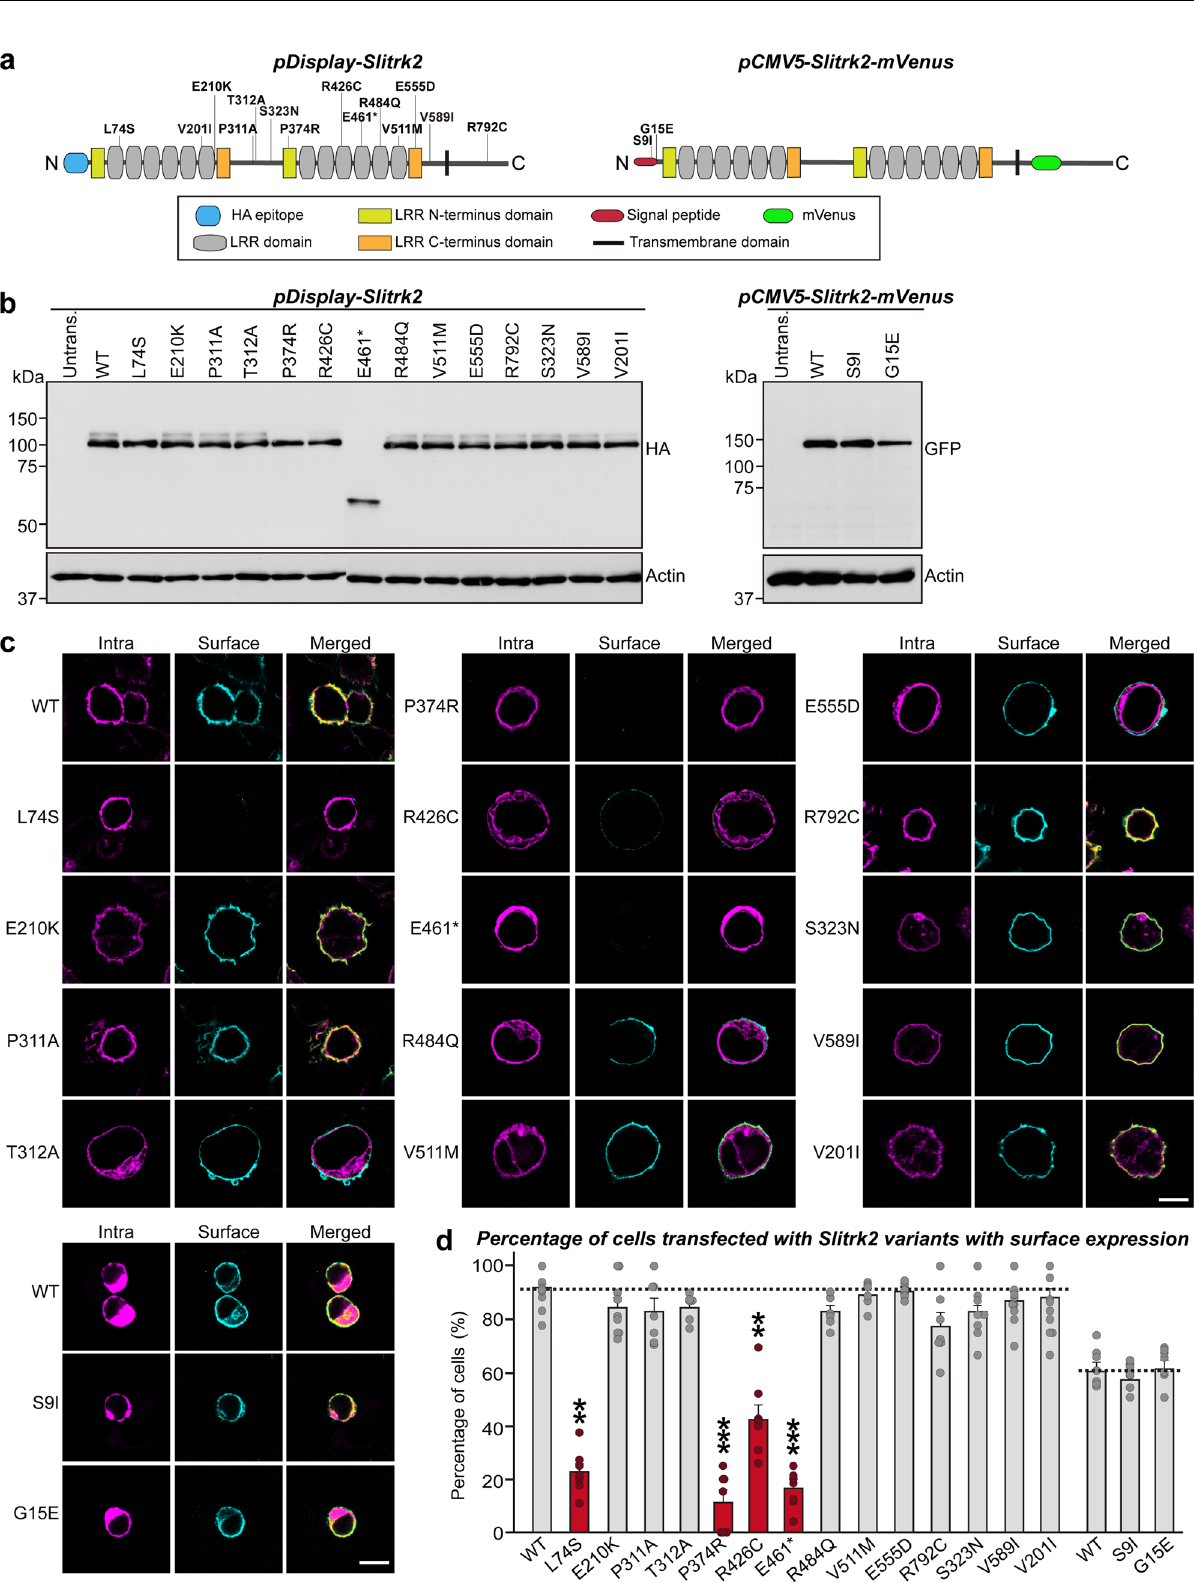
around SLITRK2-expressing HEK293T cells, whereas L74S, P374R, R426C, and E461 * were functionally inactive in recruiting both VGLUT1 and GAD67, as expected given their impaired surface expression levels and PTP-binding activities (Fig. S11; see Figs. 3c, d, S6 and S7).